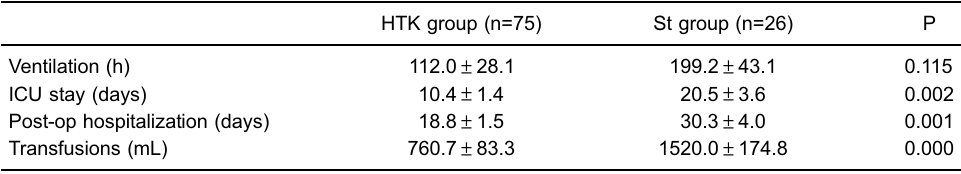
Table 4. Resource utilization of patients who underwent cardiac surgery with histidine-tryptophan-ketoglutarate (HTK) and St. Thomas ’ (St) cardioplegic solutions. HTK group (n=75)